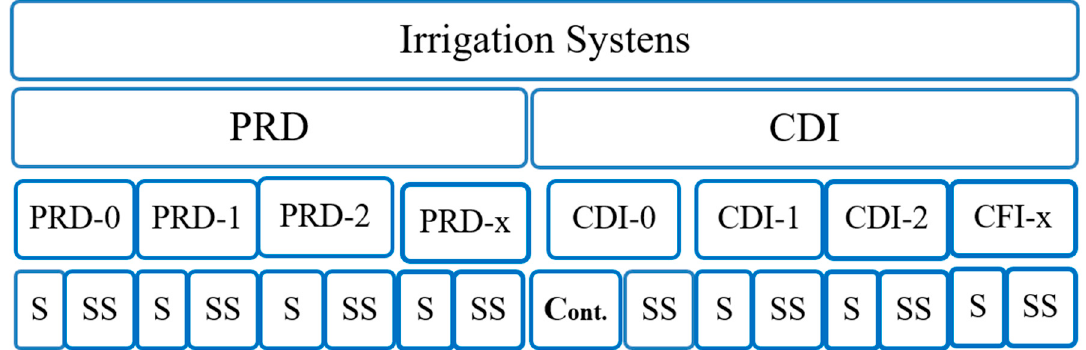
Figure 1. Layout of the experimental design for potato open field. PRD = Irrigation with a partial drying of the root zone with two double lines, with four irrigation levels. CDI = Single-line drip irrigation system, with four levels of irrigation: regular, incomplete and conventional. CFI = full drip irrigation or high irrigation. 0, 1, 2, x, = irrigation treatments at 100%, 75%, 50%, and 150% of the planned irrigation water, respectively. Control: Irrigated with conventional standard irrigation (100% conventional surface drip irrigation). S = drip irrigation. SS = subsurface drip irrigation.